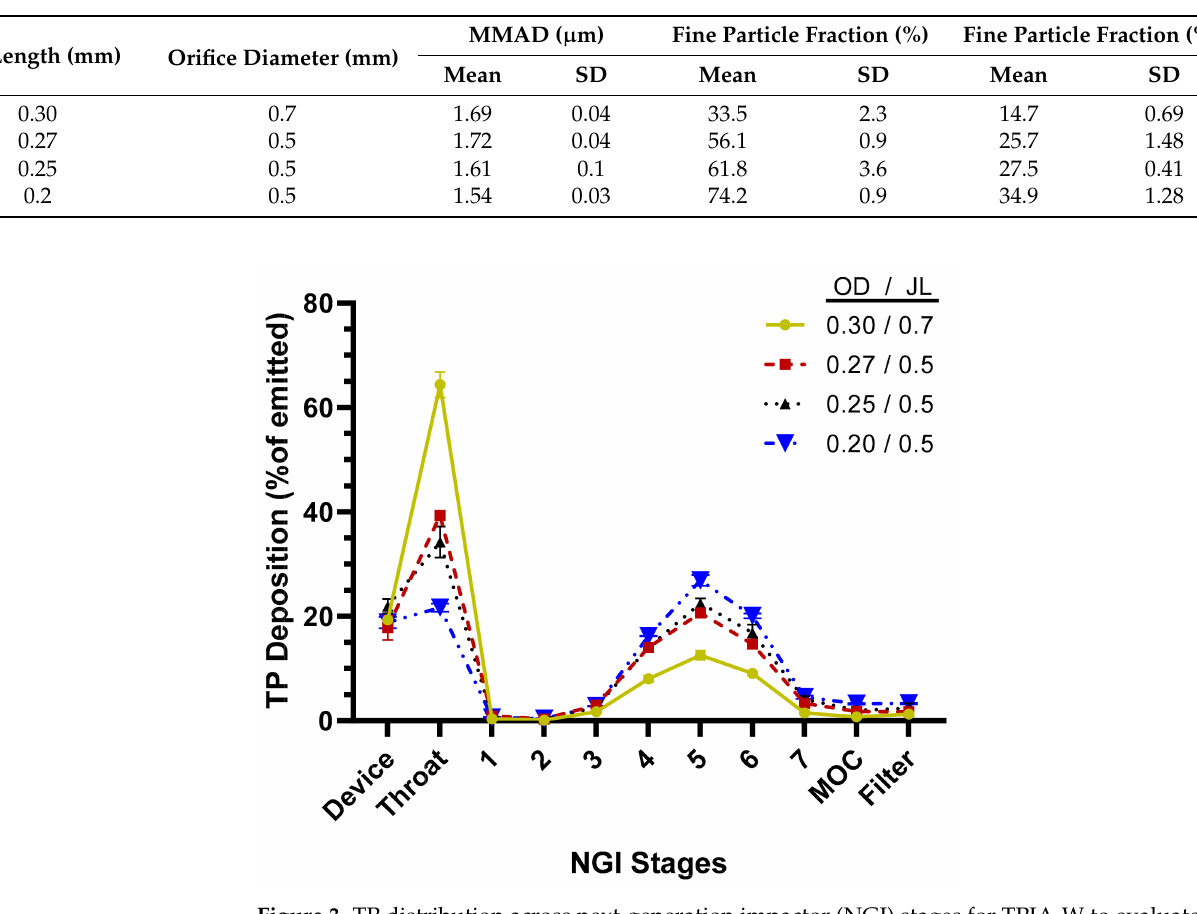
Figure 3. TP distribution across next-generation impactor (NGI) stages for TPIA-W to evaluate the effect of different actuator configurations; OD = actuator orifice diameter (mm), JL = actuator jet length